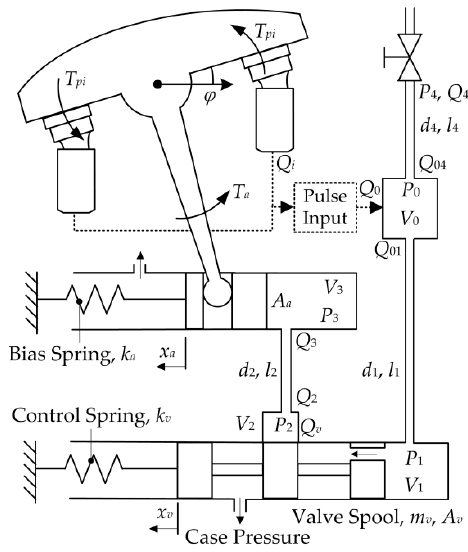
Figure 2. Variable displacement mechanism. P 0 : the pressure of the discharge chamber; V 0 : the volume of the discharge chamber; Q 0 : the input flow rate; Q 01 : the flow rate to the control valve; Q 04 : the flow rate to the load valve; P 1 : the pressure of the chamber before the valve spool; V 1 : the volume of the chamber before the valve spool; P 2 : the pressure of the chamber behind the valve spool; V 2 : the